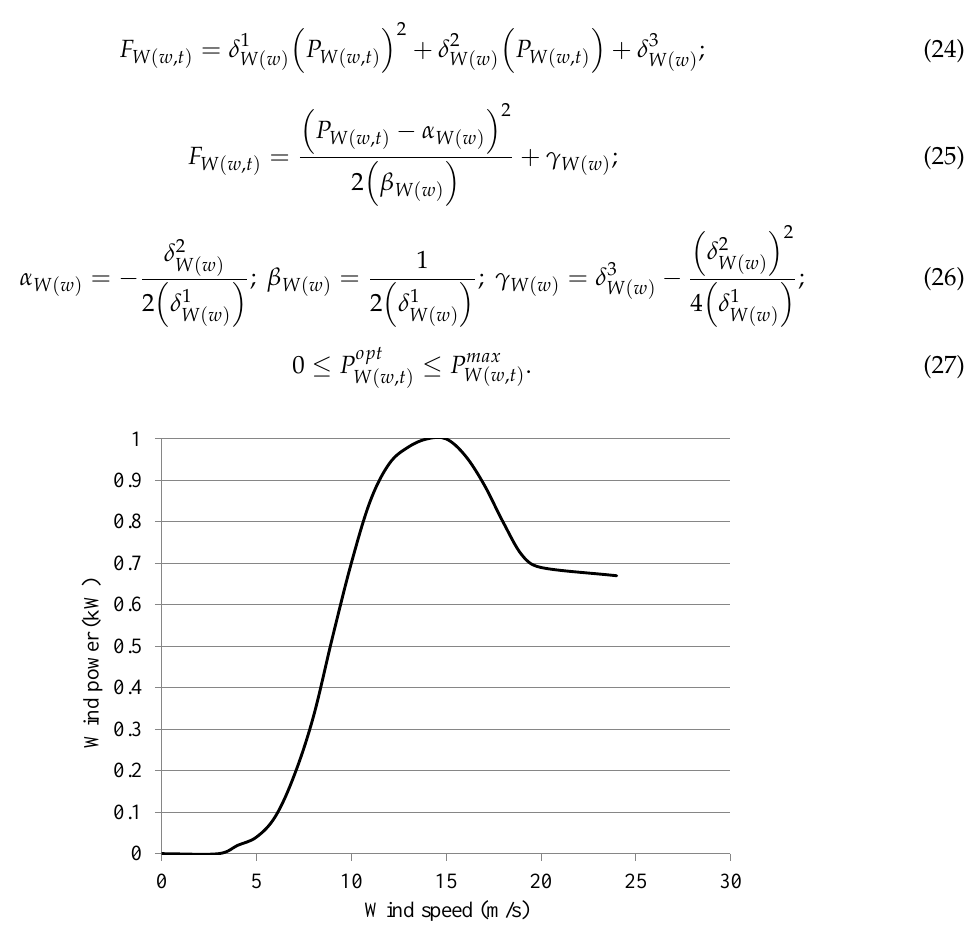
Figure 3. Wind turbine power curve.